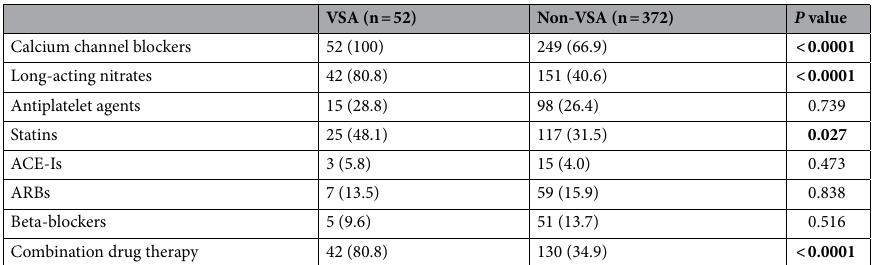
Table 3. Medical treatment during the follow-up period. Data are expressed as numbers (percentages). Abbreviations: VSA vasospastic angina, ACE-Is angiotensin-converting enzyme inhibitors, ARBs angiotensin type II receptor blockers. Significant values are in [bold].